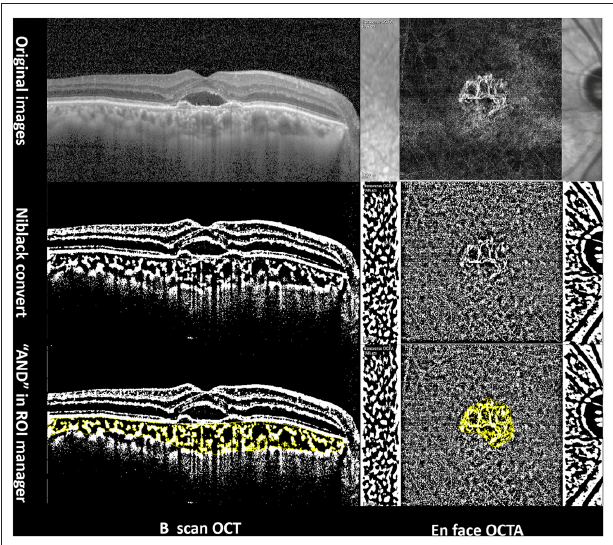
FIGURE 1 | Imaging analysis of a 65-year-old PCV patient using Image J software. Left column: choroidal vascular index in B-scan OCT. Right column: vascular density measurement of CNV in